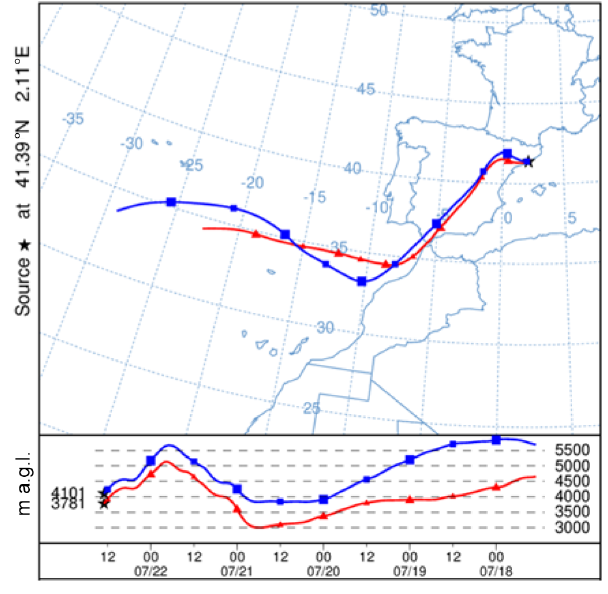
Figure 2. 5d back trajectories arriving in Barcelona on 22 July 2013, at 13:00UTC, at h min = 3781m and h max =